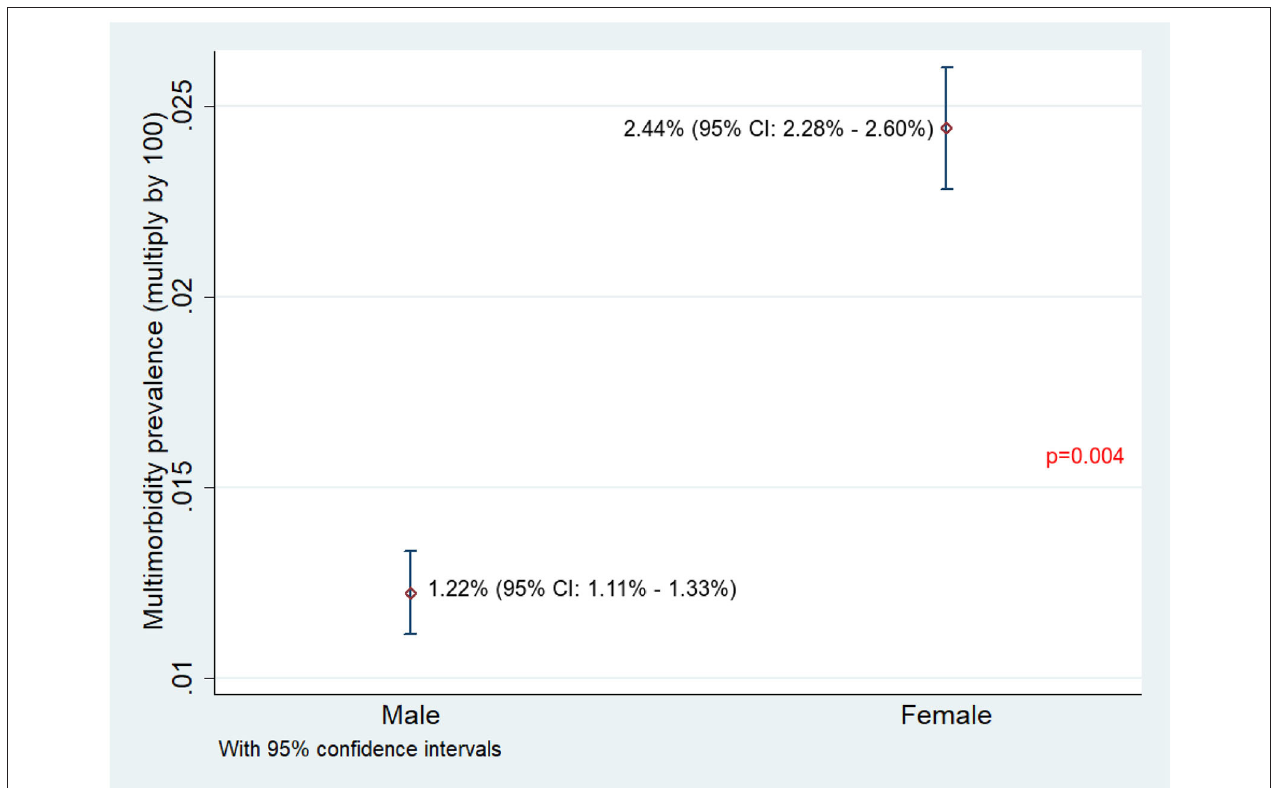
FIGURE 2 | Prevalence of NCD multimorbidity among male and female adults residing in HDSS, Gorakhpur (overall, N = 75,037; male, n = 39,071; female, n =